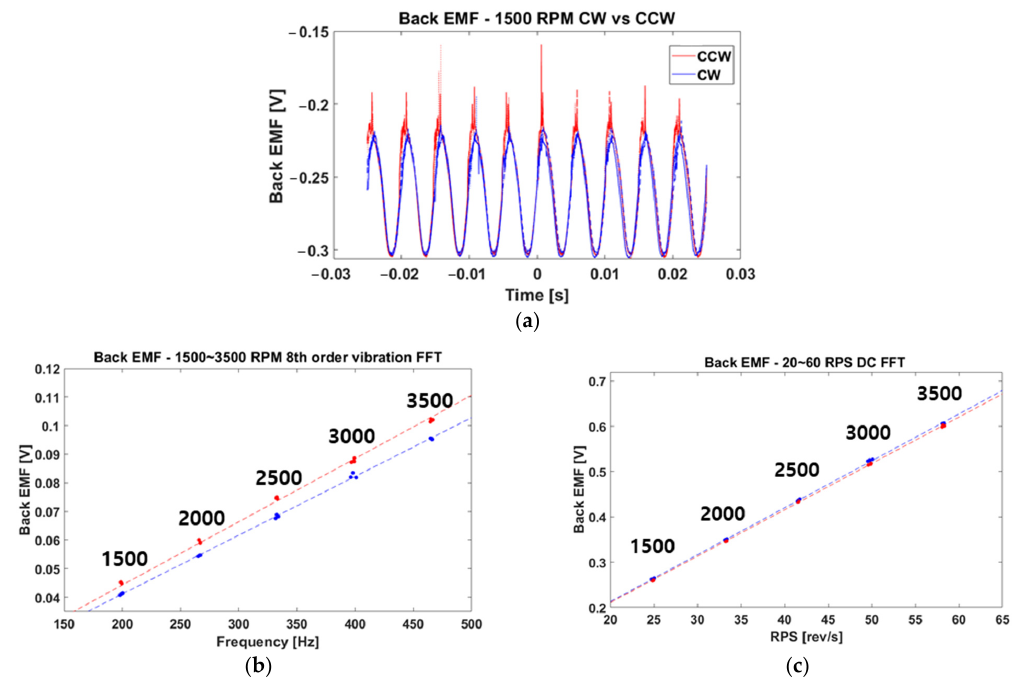
Figure 7. The result of measuring the back EMF of the sample motor with an oscilloscope. Red is CCW, blue is CW, and numbers in graphs ( b , c ) represent motor RPM. The contents of each Figure are as follows: ( a ) Back EMF time data measured with an oscilloscope at 1500 RPM; ( b ) magnitude of the eighth-order vibration component at 1500 RPM to 3500 RPM; ( c ) magnitude of the DC component at 20 RPS to 60 RPS.